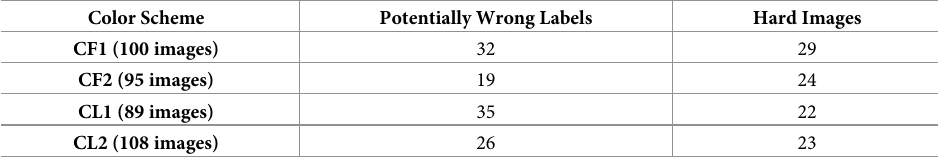
Table 8. Distribution of misclassified images.